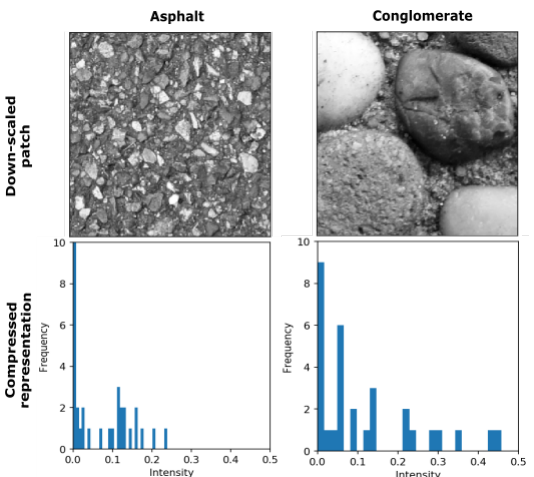
Figure 5. The encoder structure of the CAE for an image patch.